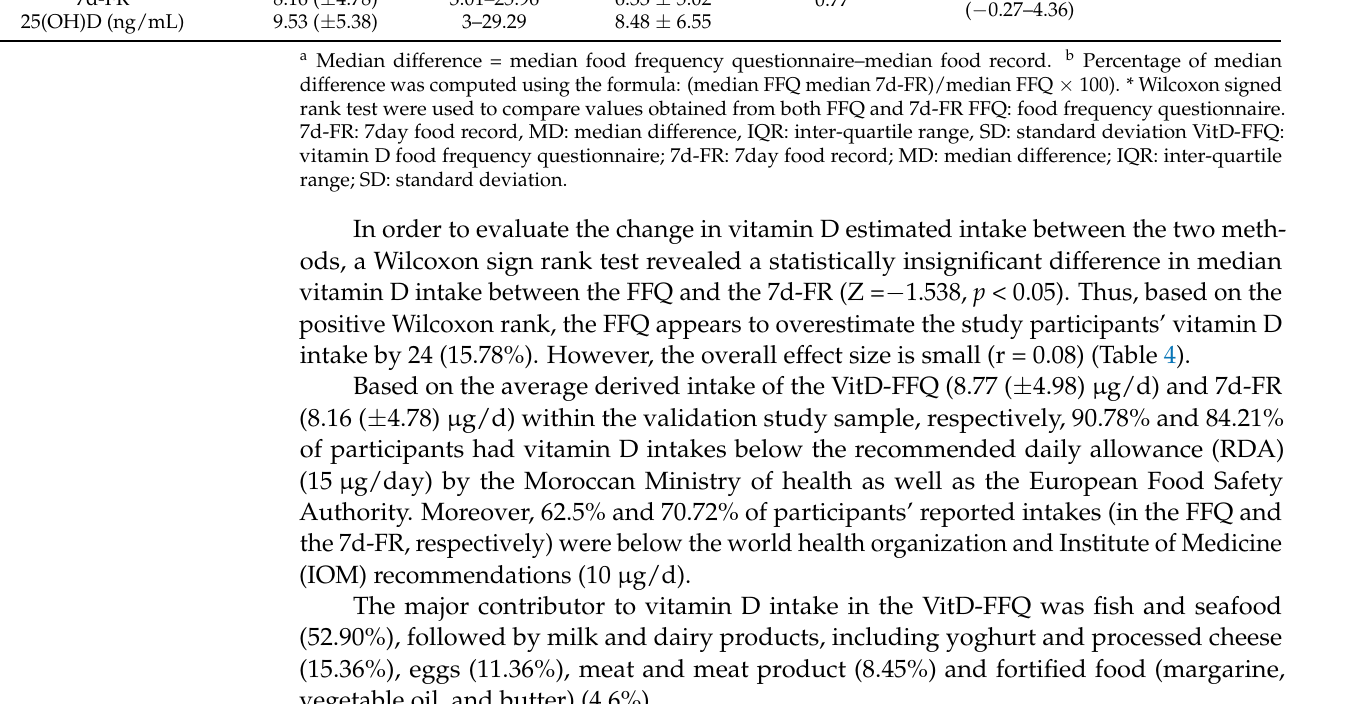
Table 5. Association between Vitamin D Status, dietary intake, UV Exposure score, BMI and socio- demographic characteristics of the